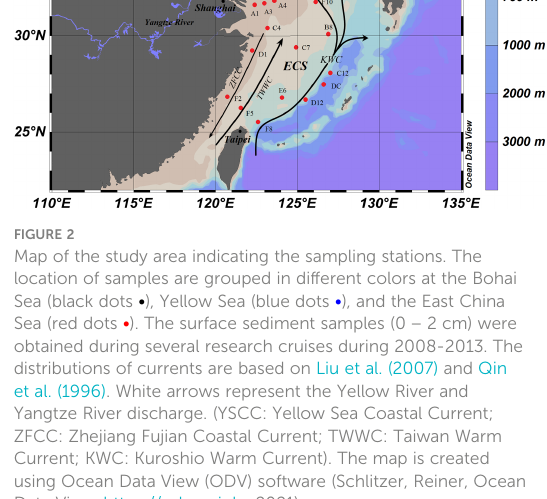
ECS (surface area: 77 × 10 4 km 2 ) (Qiao et al., 2017). The semi-